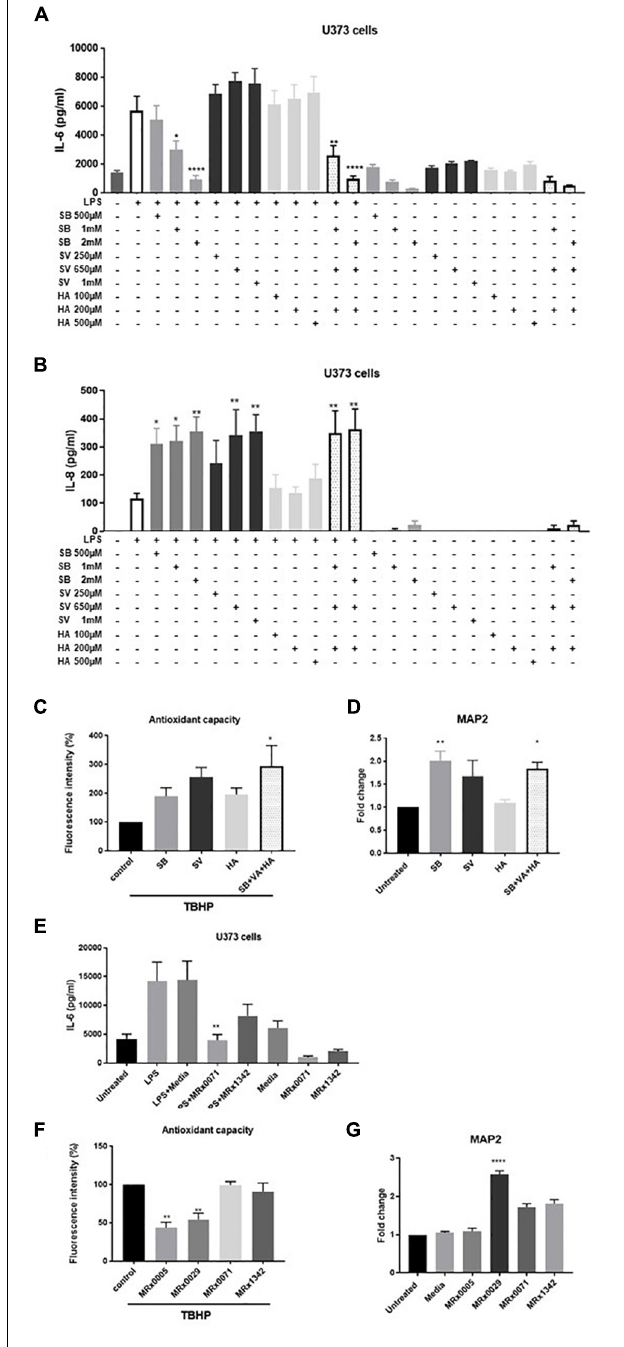
FIGURE 5 | Short-chain fatty acids effect on neuroinflammation and neuroprotection. U373 cells were treated with increasing concentrations of Sodium Butyrate (SB, 500 µ M–2 mM), Sodium Valerate (SV, 250 µ M–1 mM), or Hexanoic acid (HA, 100–500 µ M) in the presence or absence of 1 µ g/ml LPS as reported in section “Materials and Methods.” Cell-free supernatants were collected 24 h after treatment and secretion of IL-6 (A) and IL-8 (B) were measured by ELISA. Differentiated SH-SY5Y were treated with 2 mM SB, 0.65 mM SV, and 0.2 mM HA or a combination of the three SCFA at the same concentration found in 10% BCFS from MRx0029. For ROS evaluation,